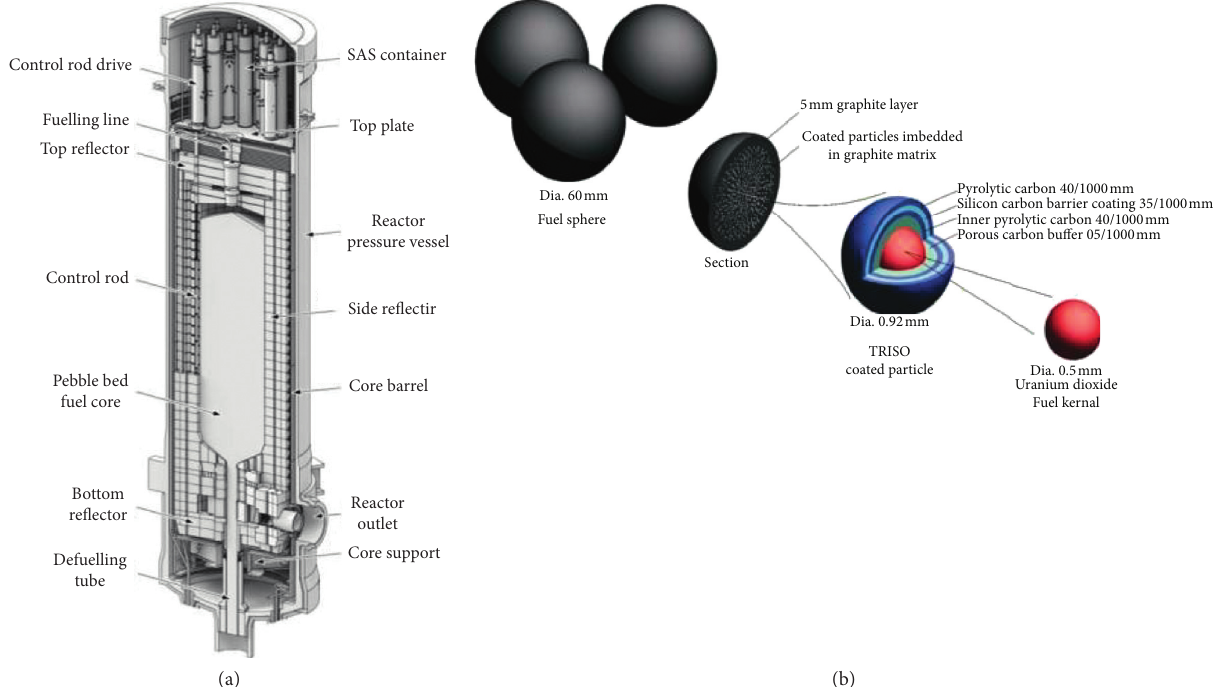
Figure 3: Pebble-bed HTGR core. (a) Core geometrical of PBR250 design [24]. (b) Fuel pebbles